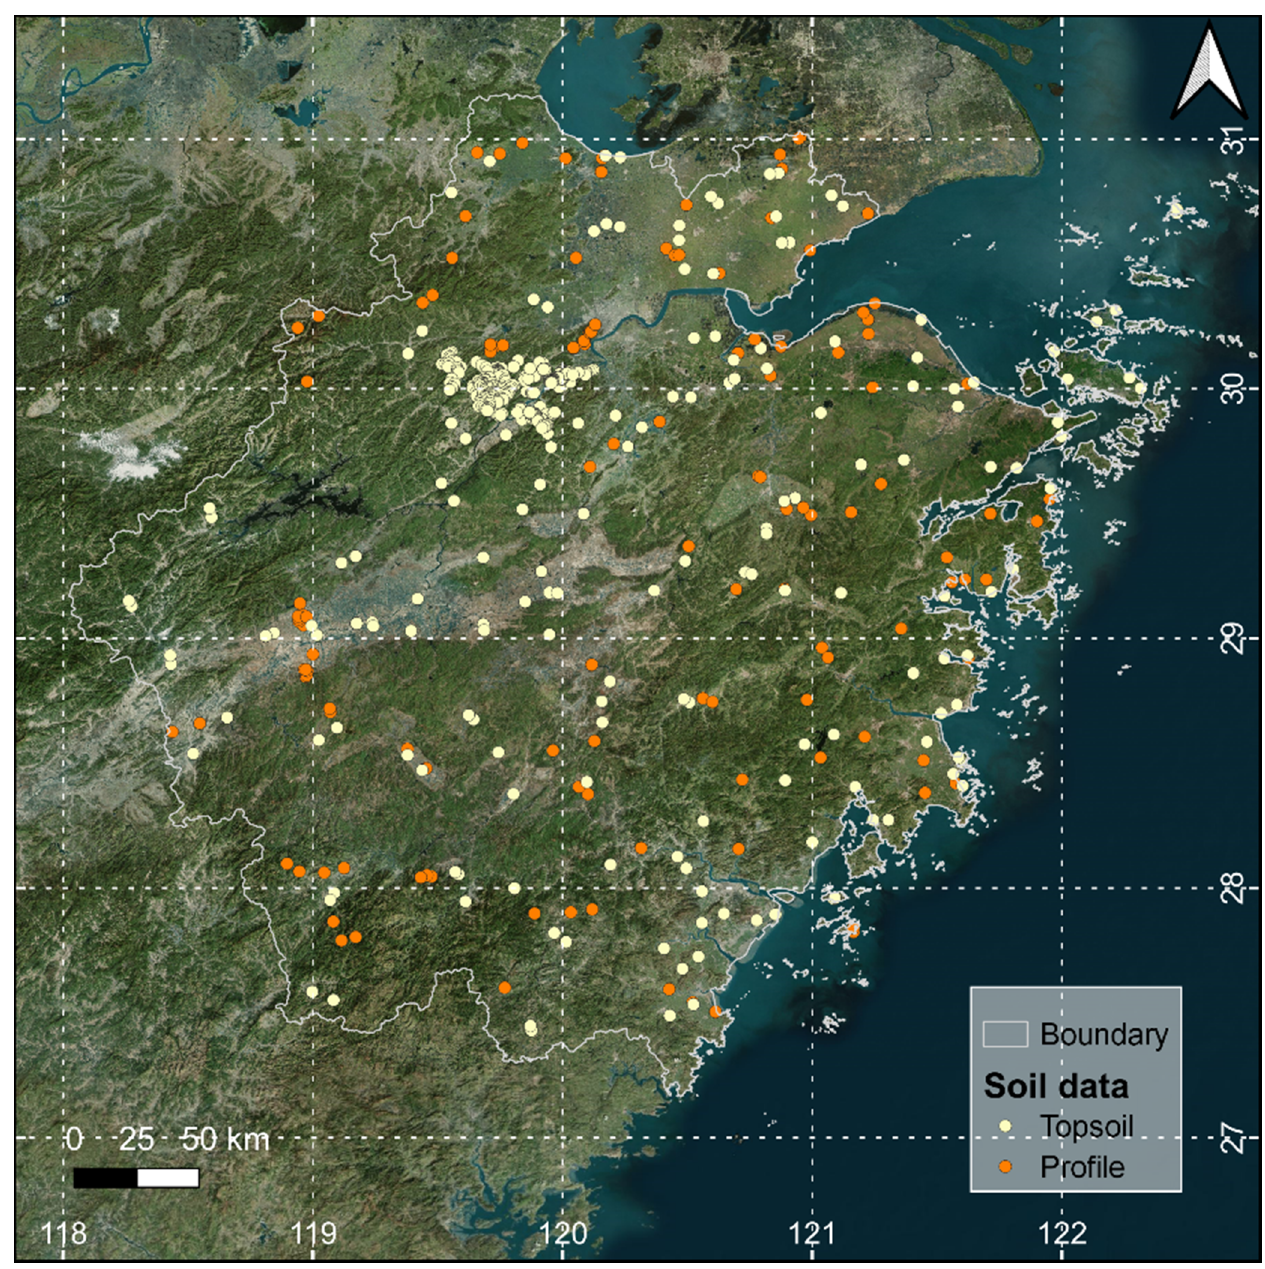
Figure 1. The location of the study area and soil sampling sites.